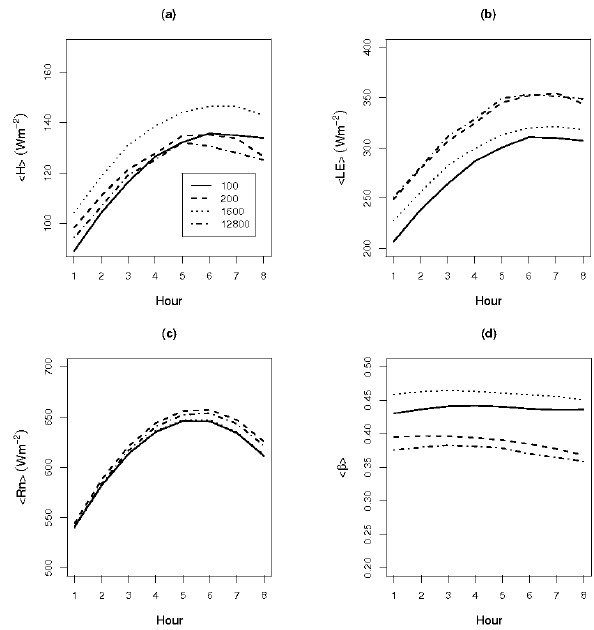
Fig. 6. Time series of the spatially averaged (a) surface heat flux [W m − 2 ] and (b) latent heat flux [W m − 2 ] (c) net radiation [W m − 2 ] and (d) Bowen ratio ( β , [ − ]) for each level of